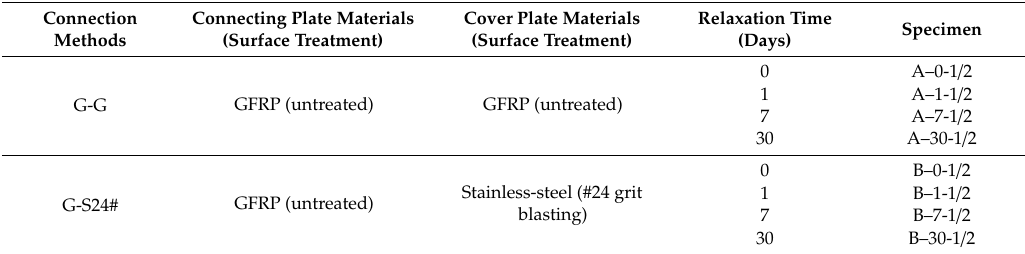
Table 6. Specimens in the pre-tension force relaxation tests.